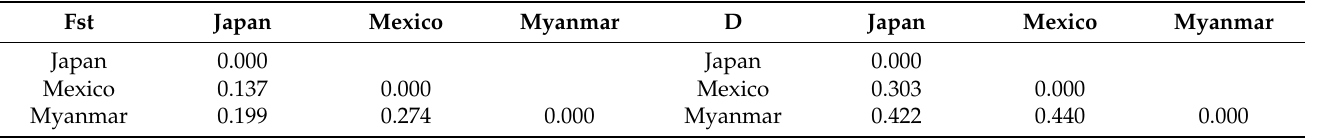
Table 3. Pairwise Population Matrix of Wright’s Fst Values and Nei’s Genetic